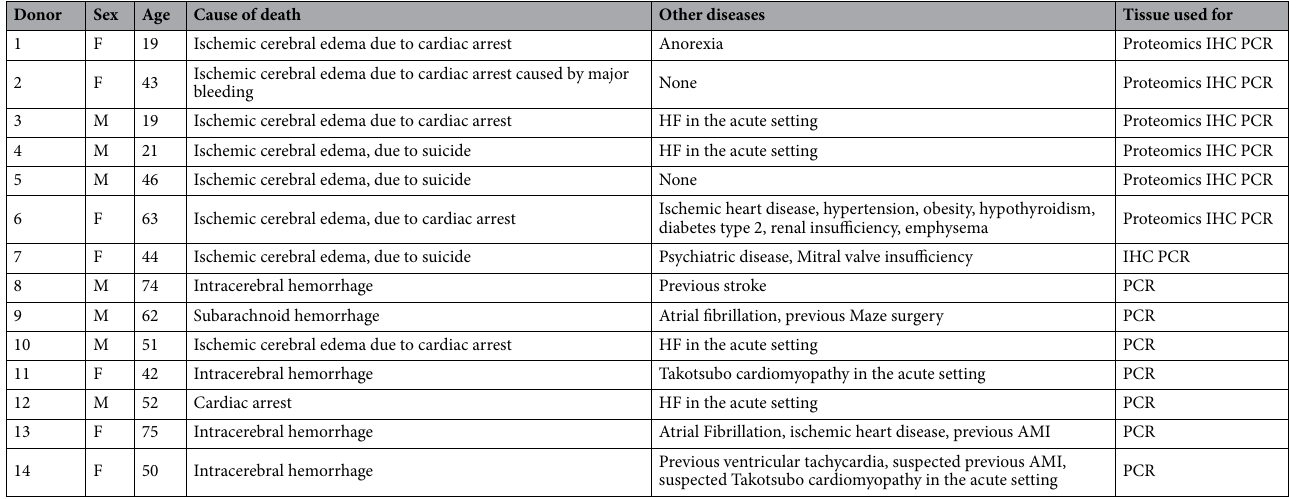
Table 1. Clinical background of included multi-organ donors. Table summarizes the clinical background of the organ donors not suitable for the cardiac transplantation. F = female, M = Male, AMI = Acute Myocardial Infarction, HF = Heart Failure, Proteomics = Global Quantitative proteomics, IHC = Immunohistochemistry, PCR = Polymerase chain reaction.